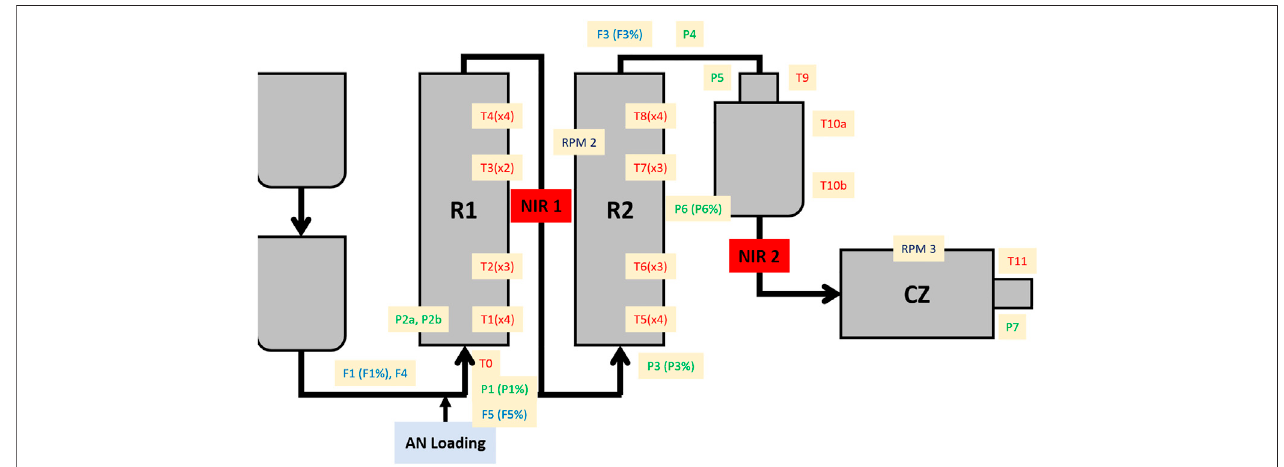
FIGURE1| SchematicrepresentationoftheSANproductionplant.R1 (cid:1) fi rstreactor;R2 (cid:1) secondreactor;NIR1 (cid:1) fi rstNIRprobe;NIR2 (cid:1) secondNIRprobe;CZ (cid:1) cutting zone; AN (cid:1) acrylonitrile; T (cid:1) temperature sensors; P (cid:1) pressure sensors; F (cid:1) fl ow sensors; RPM (cid:1) motor speed sensors. A percentage symbol after the sensor name indicates the opening extent of a valve linked to the speci fi c